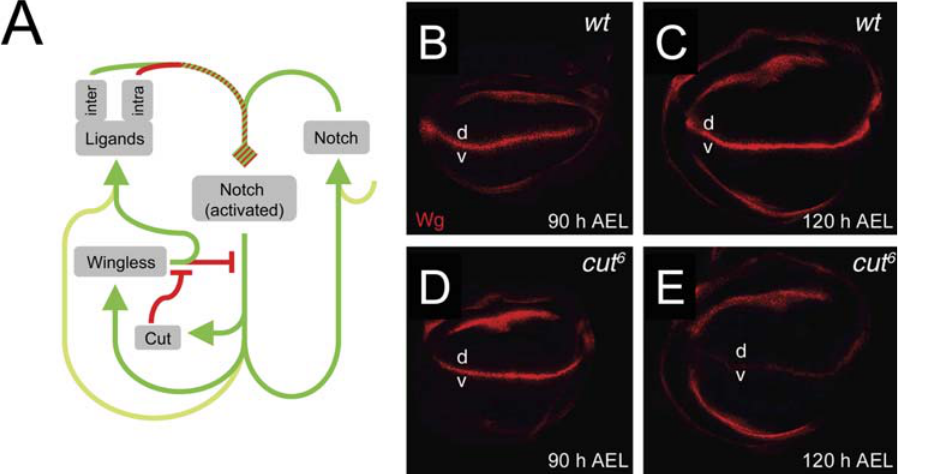
Figure 6. Proposed regulatory network for the establishment of the DV boundary: Cut renders stability to the DV boundary. (A) Proposed regulatory network for stable formation and maintenance of the DV boundary. The network includes the capacity of boundary cells, defined by the activity of Cut, to block the Wg signaling pathway at all levels (both positive and negative regulations). (B–E) Wg expression in wild-type (B, C) or cut 6 mutant (D, E) wing discs at 90 hr (B, D) or at 120 hr (C, E) after egg laying